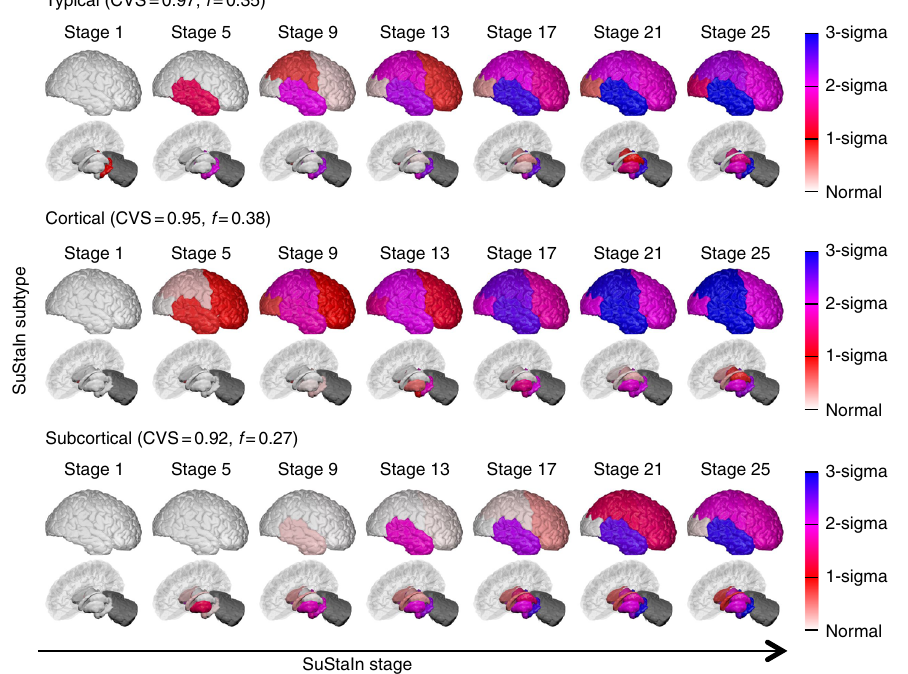
Fig. 3 SuStaIn modelling of sporadic Alzheimer ’ s disease using ADNI data. The rows show the progression pattern of the three subtypes identi fi ed by SuStaIn. Diagrams as in Fig. 2, but the z -scores are measured relative to amyloid-negative (cerebrospinal fl uid A β 1 – 42 > 192 pg per ml) cognitively normal subjects, i.e. cognitively normal subjects with no evidence of amyloid pathology on cerebrospinal fl uid. The cerebellum was not included as a region in the Alzheimer ’ s disease analysis and so is shaded in dark